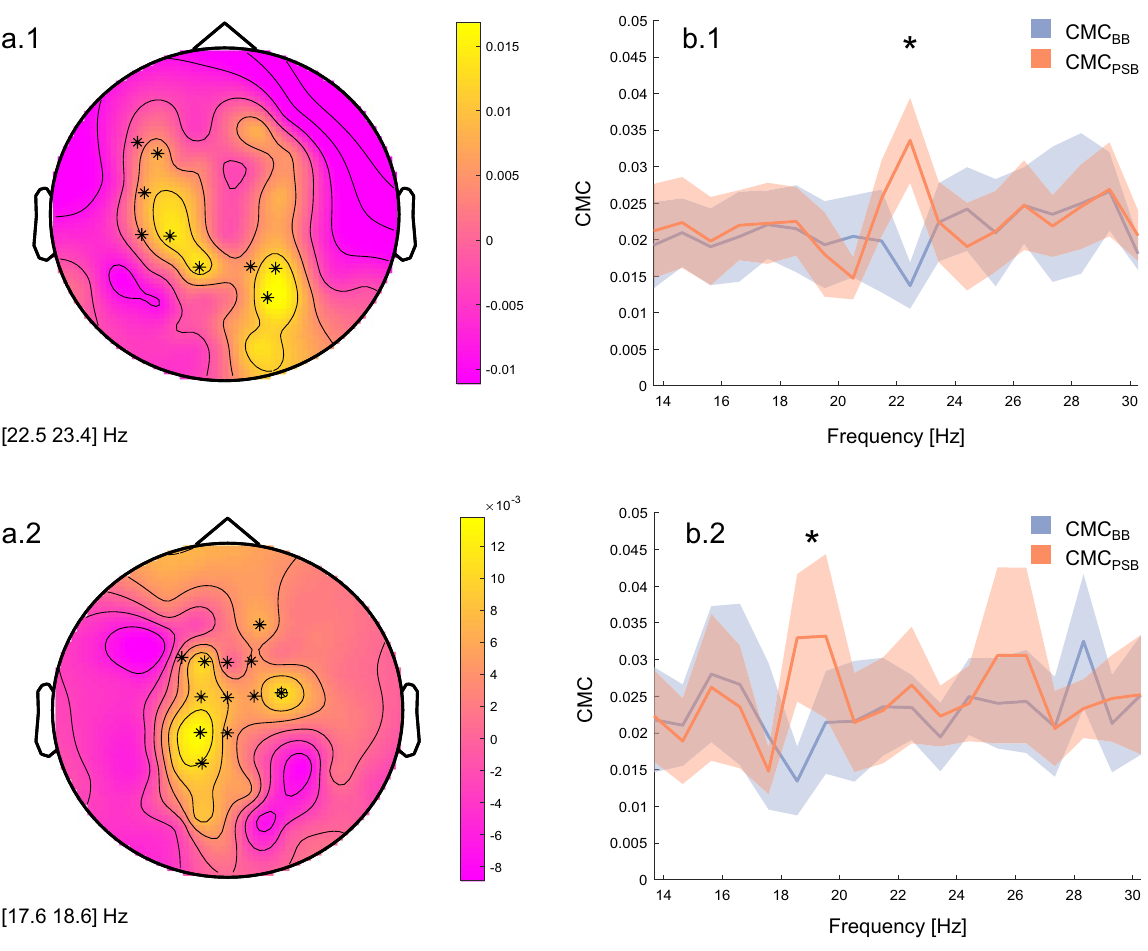
Figure 2. Corticomuscular coherence topographic maps and spectra. On the left-side, voltage topographic maps of the difference between EMG-EEG couplings before and EMG-EEG couplings after the WBVs (CMC BB and CMC PSB , respectively), averaged across subjects, are reported for the right GL ( a.1 ) and the right SOL ( a.2 ). The asterisks depict electrodes that showed a significantly bigger CMC around 23 Hz ( a.1 ) and 19 Hz ( a.2 ). On the right-side, CMC spectra (mean ± standard error) of EMG-EEG couplings before and after the stimulation are reported for the right GL ( b.1 ) and the right SOL ( b.2 ). The asterisks depict the frequency bin at which the CMC signals differed between conditions, as identified by the cluster-based permutation test. Results are shown for CMC vectors obtained from the 45 s-long baseline (BB) and post-stimulation (PSB)